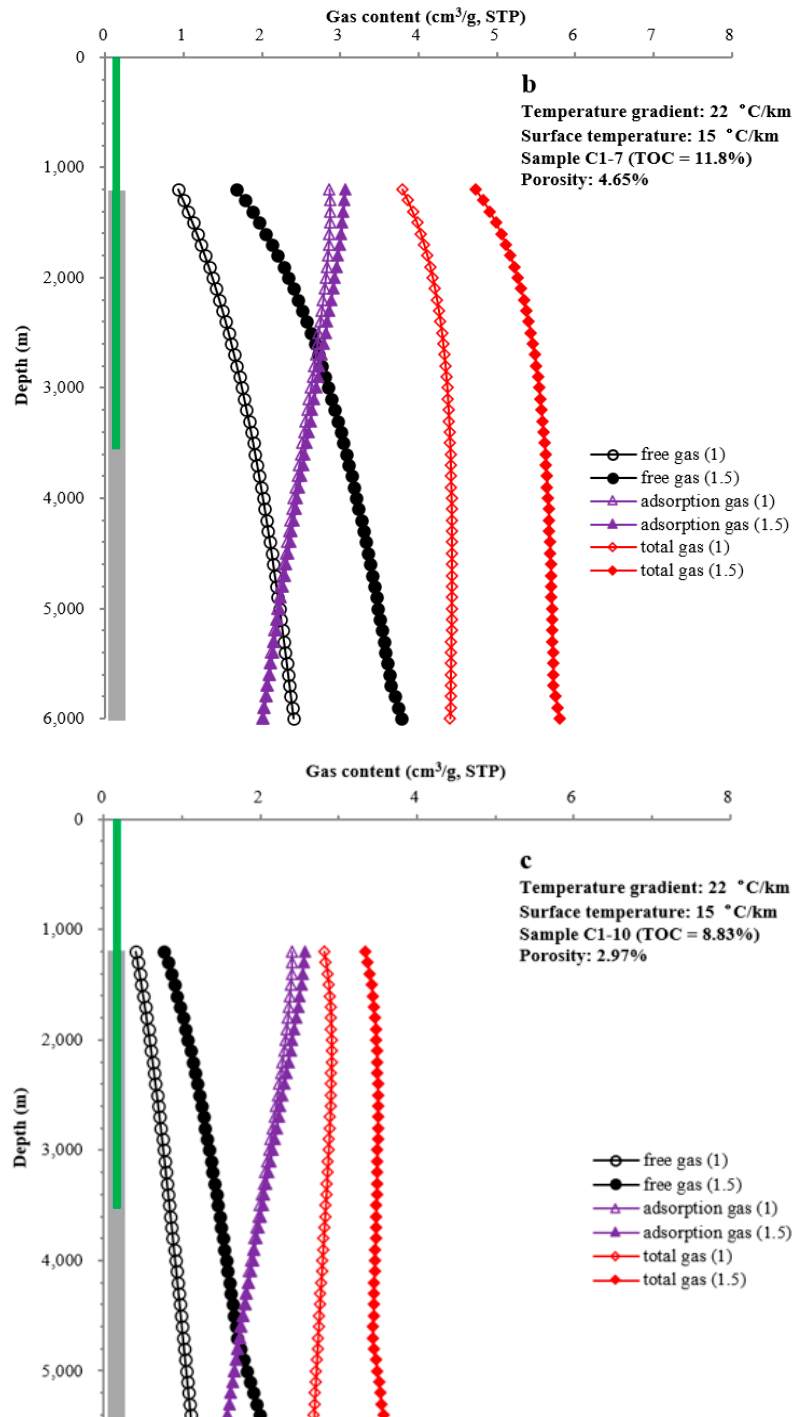
Figure 12. The MSC models of the Permian shale reservoirs based on difference TOC content samples (( a ) Sample C1-4 with a TOC content of 1.36% and a total porosity of 2.09%. ( b ) Sample C1-7 with a TOC content of 11.8% and a total porosity of 4.65%. ( c ) Sample C1-10 with a TOC content of 8.83% and a total porosity of 2.97%). The numbers in legend mean the fluid pressure coefficient. The water saturation is 20% for reservoir with a pressure coefficient of 1.5 and 30% for reservoir with a pressure coefficient of 1.0. The geothermal gradient is 22 ◦ C/km with a surface temperature of 15 ◦